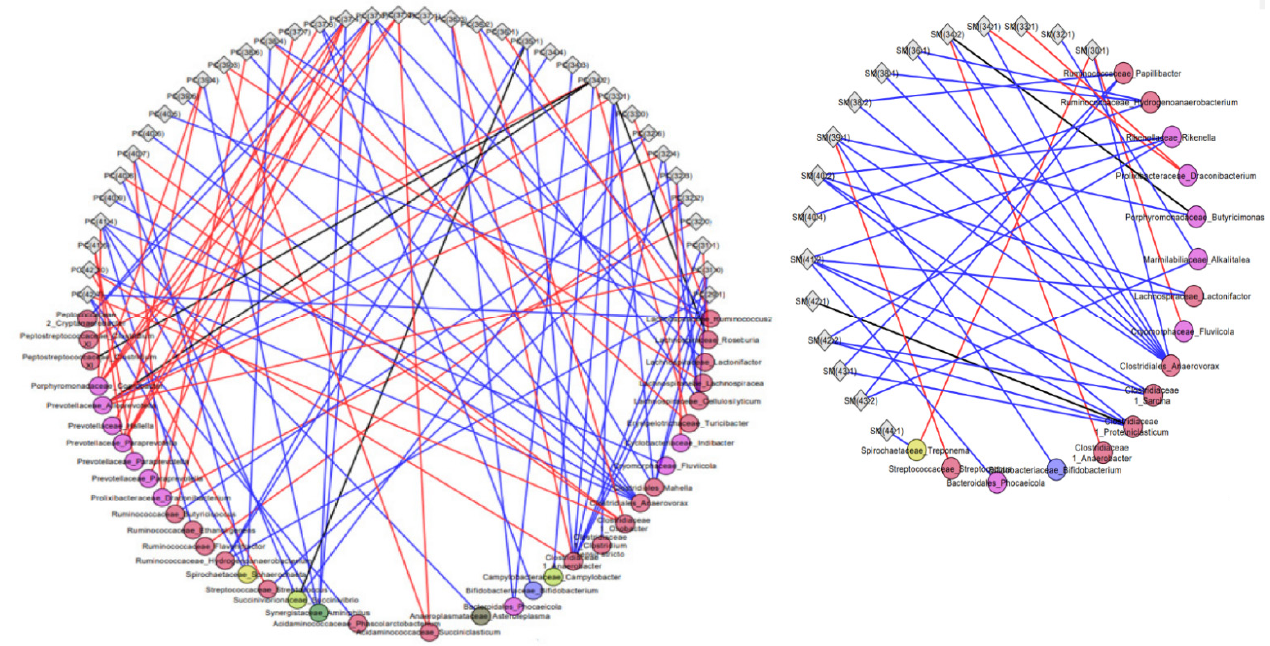
Figure 7. Bacteria-metabolite network visualization in the liver of pigs fed six servings of a WBM-supplemented diet. Bacterial genus in the fecal microbiome and the most abundant metabolite lipid species phosphatidylcholine and sphin- gomyelin compared between pigs fed six servings of WBM versus control diets. Bacterial genus is represented by circles, liver metabolites are represented by diamonds. Change from negative to positive correlation are shown in blue, while change from positive to negative in shown in red. Only significant correlations are shown ( p -value < 0.05).